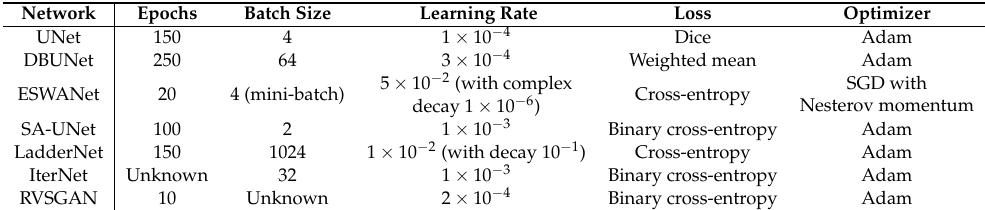
Table 1. CNN training hyperparameters, as reported in the papers. A value of Unknown is where we were unable to find the information.